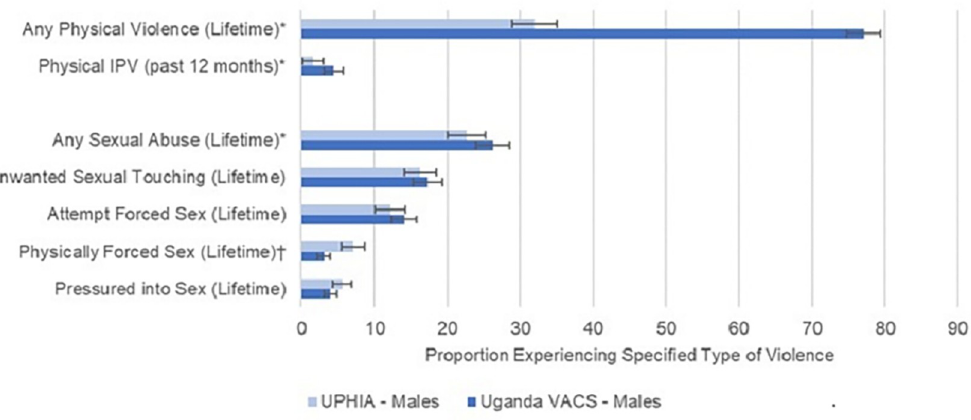
Fig 1. Lifetime and past-12-month prevalence of sexual and physical violence in males aged 15–24 years in Uganda Population-based HIV Impact Assessment (UPHIA 2016–2017) and Uganda Violence Against Children Survey (VACS 2015). Violence domains include lifetime physical violence, physical intimate partner violence (IPV) in the past 12 months, and lifetime sexual violence. Asterisks ( � ) indicate significantly higher prevalence in VACS than UPHIA (p < 0.05). Daggers ( † ) indicate significantly higher prevalence in UHPIA than VACS (p < 0.05).